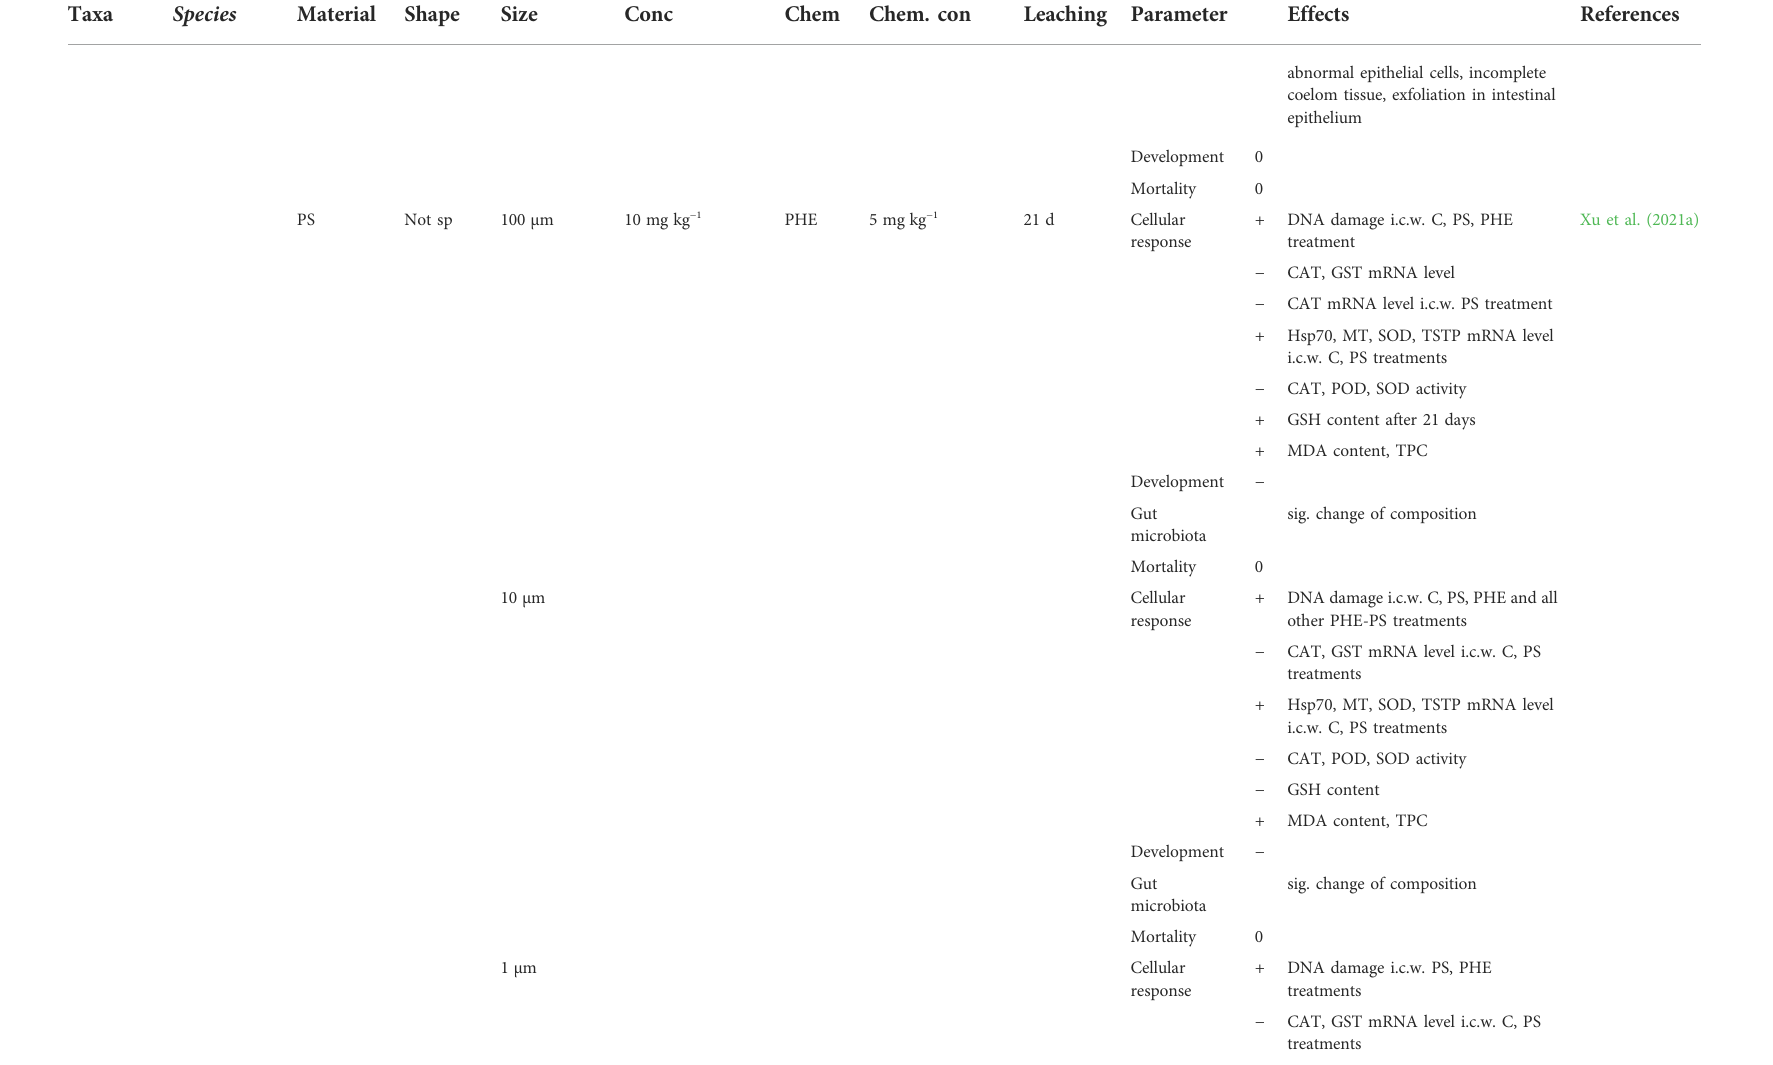
TABLE 6 ( Continued ) In fl uence of microplastics on the bioavailability of environmental chemicals in soil